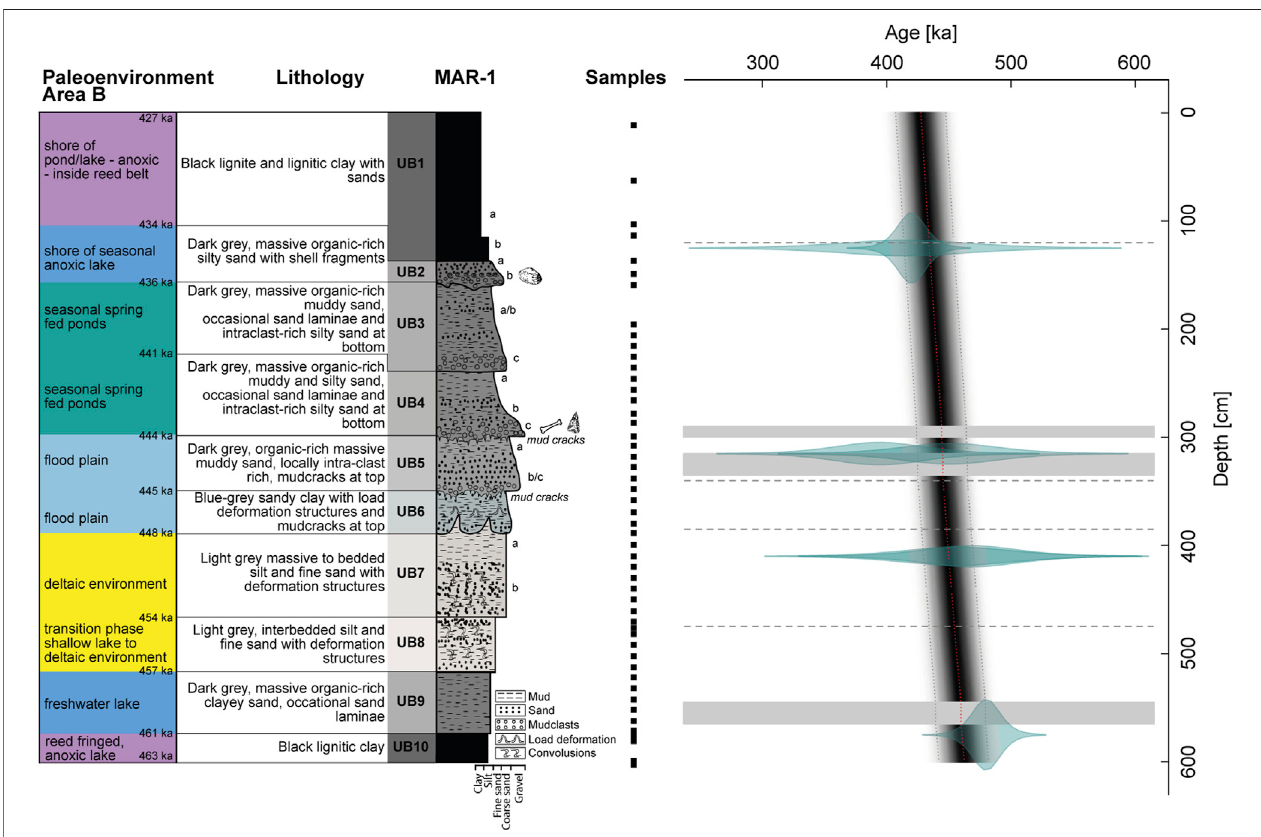
FIGURE 3 | The paleoenvironmental interpretation, sample positions and age-depth model (Bacon v2.3.9.1) (this study) in context with the lithological description from Karkanas et al. (2018) of MAR-1 Area B. Right panel: age-depth model. Grey shades: calculated ages (darker indicates more likely ages). Dotted lines: 95% con fi dence interval. Dashed lines: sequence boundaries. Grey bars: slump structures. Transparent green: input ages with error margins.